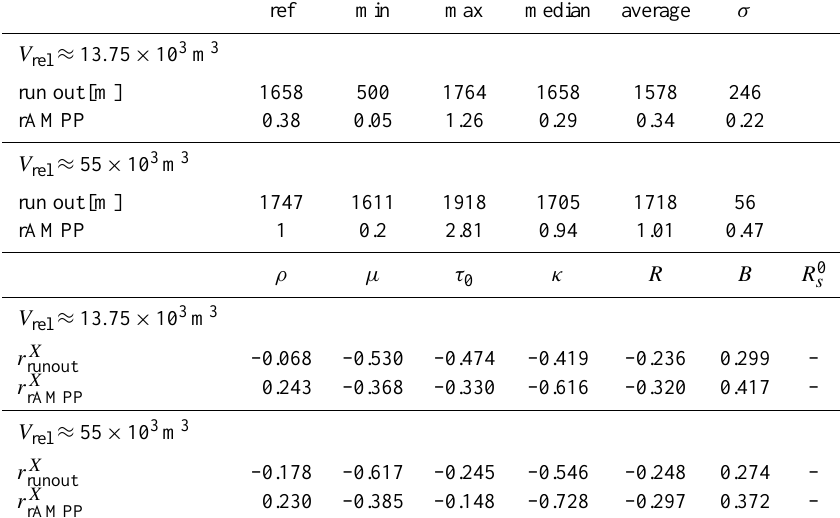
Table 2. Distribution of run out and rAMPP for both ( V rel ≈ 13 . 75 × 10 3 m 3 and V rel ≈ 55 × 10 3 m 3 ) model parameter variation scenarios. Shown is reference, minimum, maximum, median and average value with according standard variation. Additionally Spearman’s